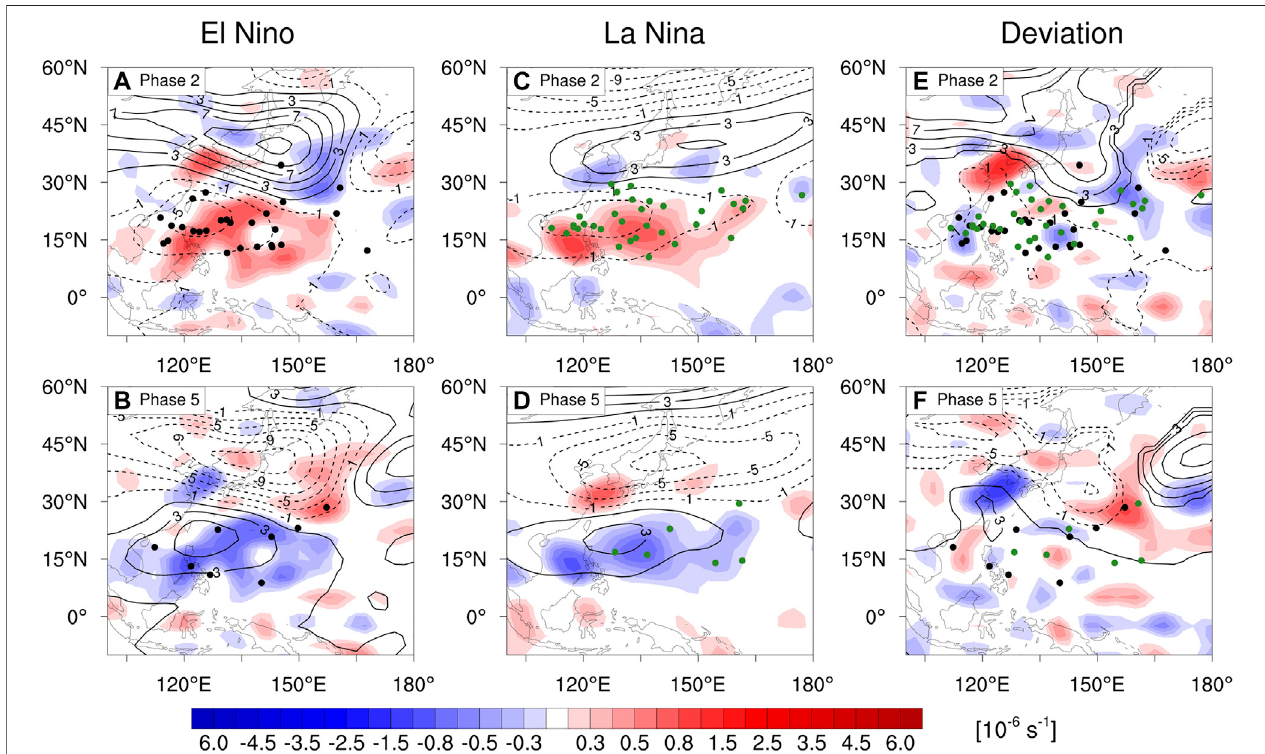
FIGURE 9 | The composition of divergence (s − 1 , shaded) at 200 hPa and geopotential height at 500 hPa (gpm, contour) with the period of 20 – 30 days for El Niño years (A – B) and 50 – 70 days for La Niña years (C – D) and their difference (El Niño minus La Niña) fi elds (E – F) based on the phase of the EAP index. The differences passing the 95% con fi dence level are plotted. The black (green) dots represent the positions of MTC genesis in El Niño (La Niña)